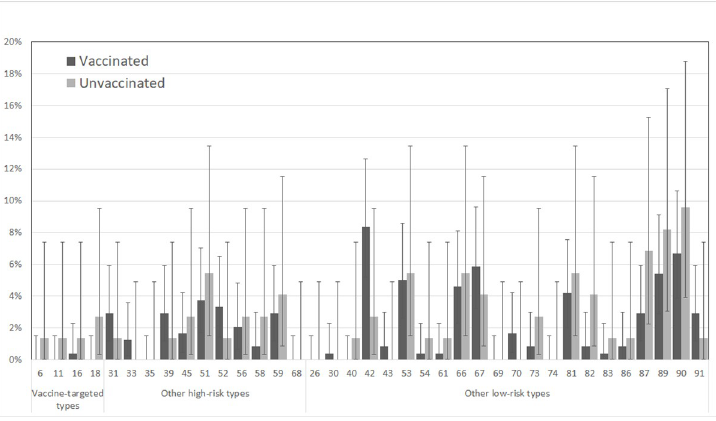
Fig 2. Prevalence of human papillomavirus (HPV) types in vaginal samples by HPV vaccination status. Error bars show 95% confidence intervals.